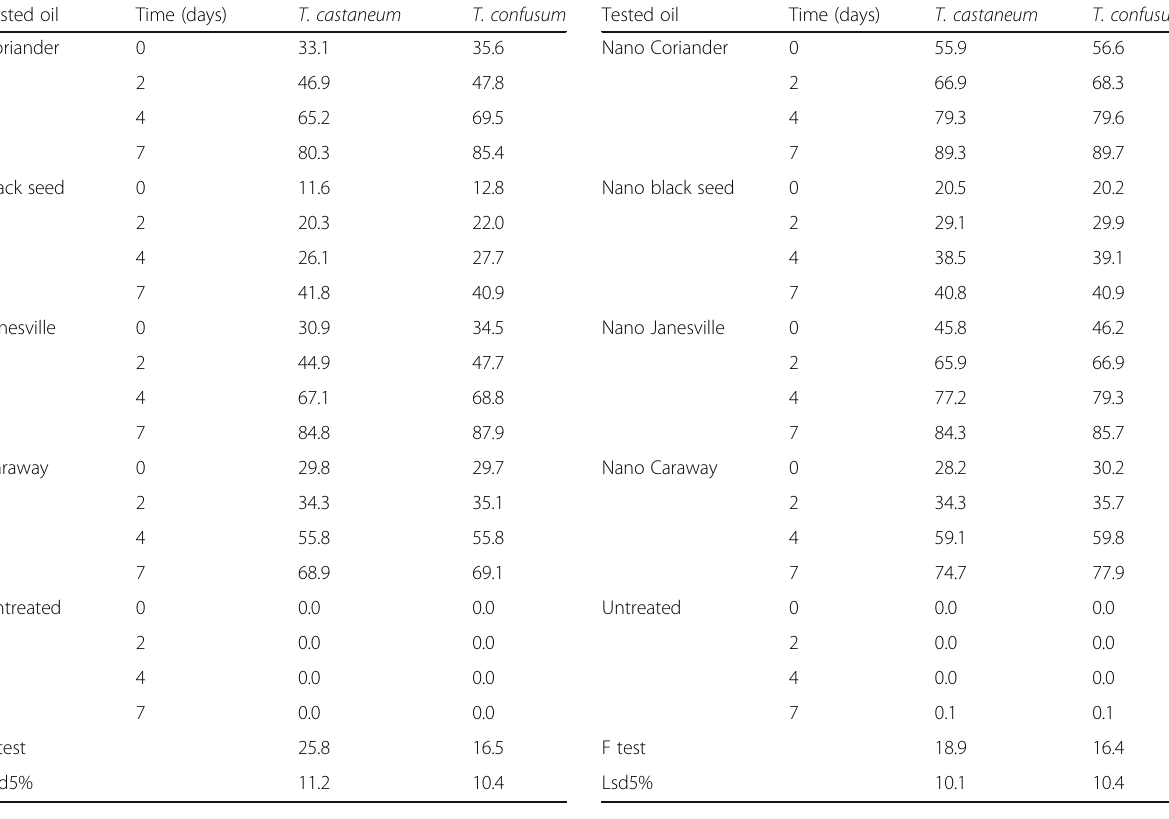
Table 2 The accumulative mortality of T. castaneum and T. confusum during the first week of treated foam with different tested nano